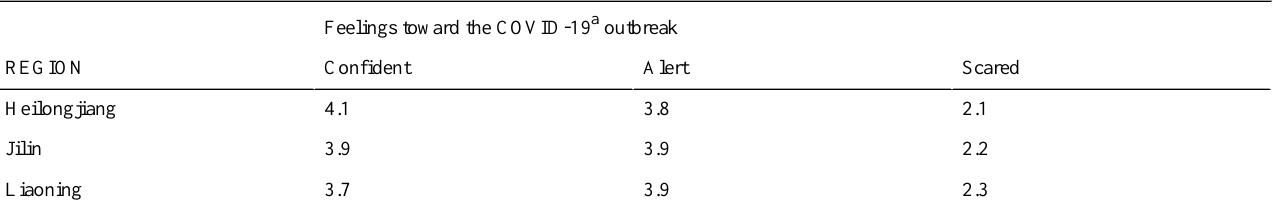
Table 5. Online survey results regarding awareness of COVID-19 control and prevention from three provinces in northeastern China. Participants ranked their feelings from 0-5, where 5 was the strongest